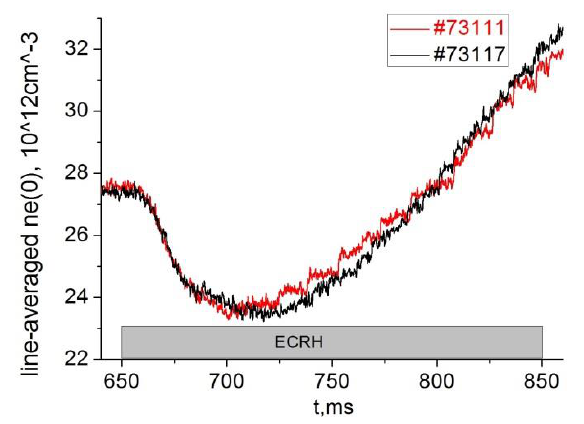
Fig. 9. Line-averaged (0) time evolution, shot #73111- co+contr ECCD, shot #73115- co+co ECCD.